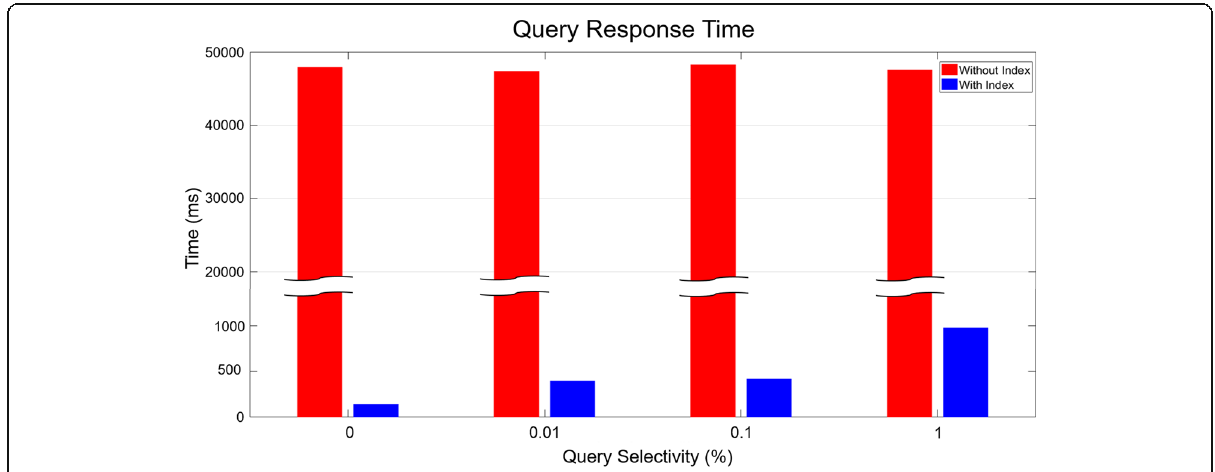
Fig. 10 Query response time depending on query